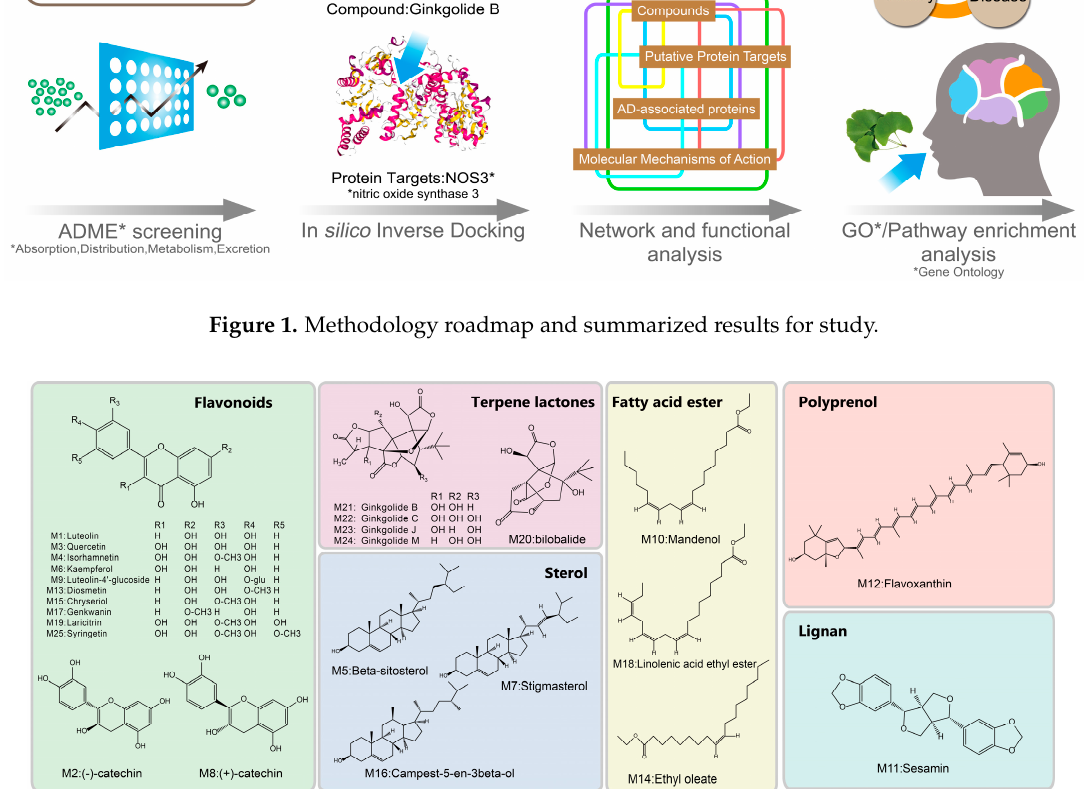
Figure 3. Illustration of the Compound–Target (CT) network. ( a ) Orange circles represent candidate compounds that are grouped together by structural category. The blue square represents the putative